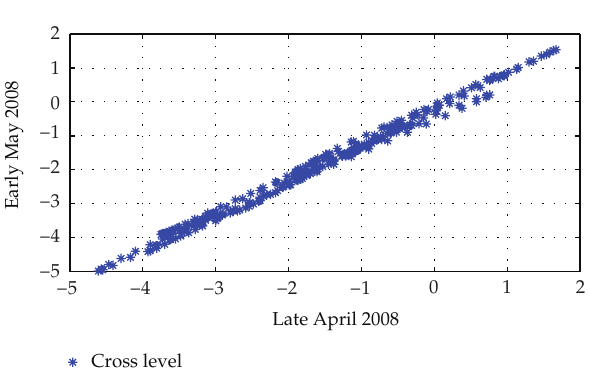
Figure 2: Scatter diagrams of detection data during the last ten-day period of April and the first ten-day period of May,